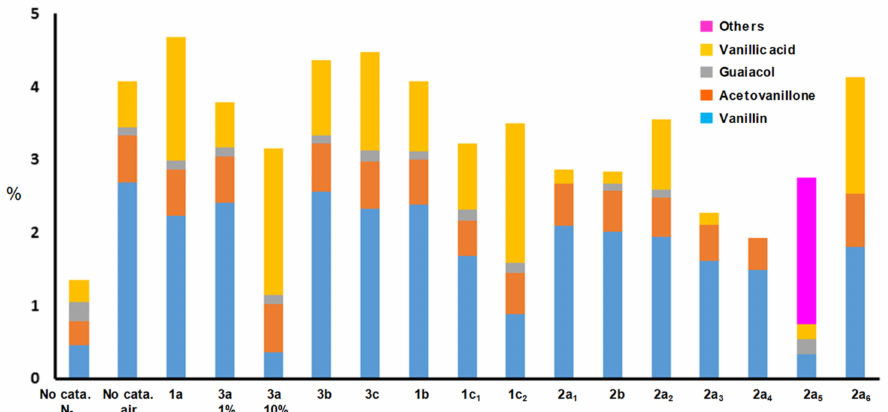
Figure 10. Influence of the catalysts on the yields of aromatic contained in the organic phase after lignin depolymerization (150 ◦ C, P air 20 bar, 1 h, C lignin 5 g L − 1 , C NaOH 10 g L − 1 , C M 0.05–0.5 g L − 1 [M = Pd or Au]); 1% refers to a mass of Pd corresponding to 1% wt of the lignin giving a Pd loading of 0.05 g L − 1 , and 10% refers to a mass of Pd corresponding to 10% wt of the lignin giving a Pd loading of 0.5 g L − 1